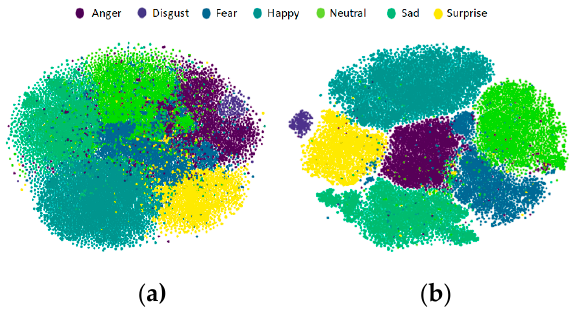
Figure 9. Visualization study of ( a ) VGG-16 FACE and ( b ) DenseNet121-FC.